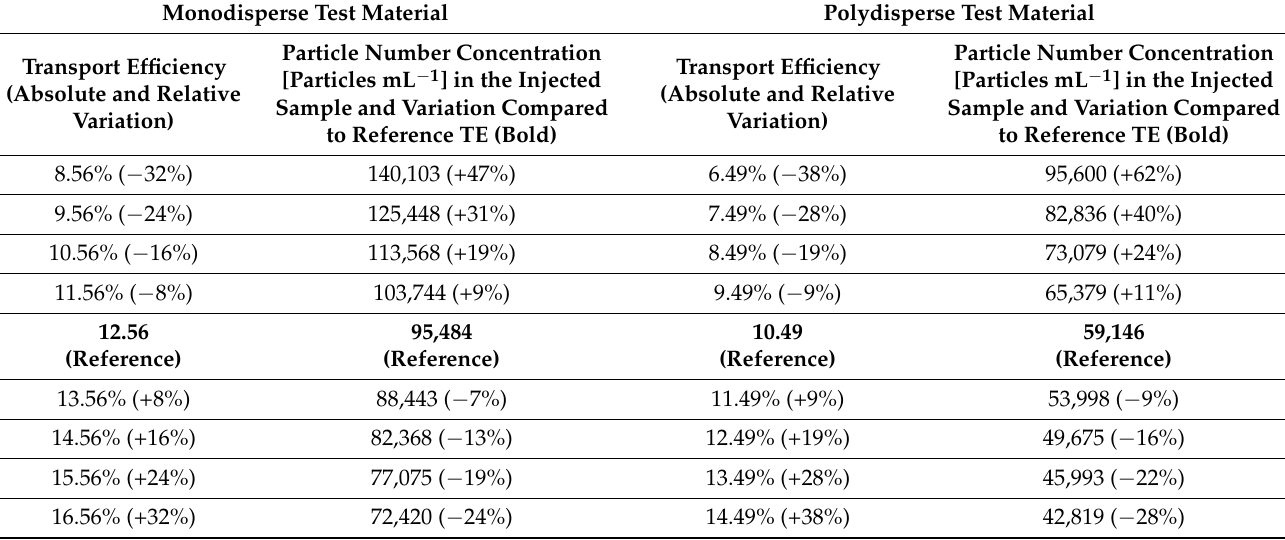
Table 9. Impact of variations of transport efficiency on the particle number concentration.